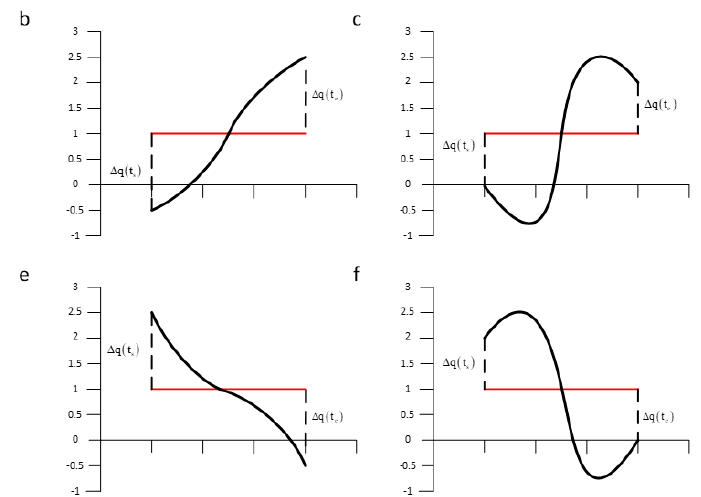
Figure 3. Several typical segments with the same average value and same trends but different boundary distance. Segment b and c , e and f with the same SAX representation and trend distance while they are different segments.